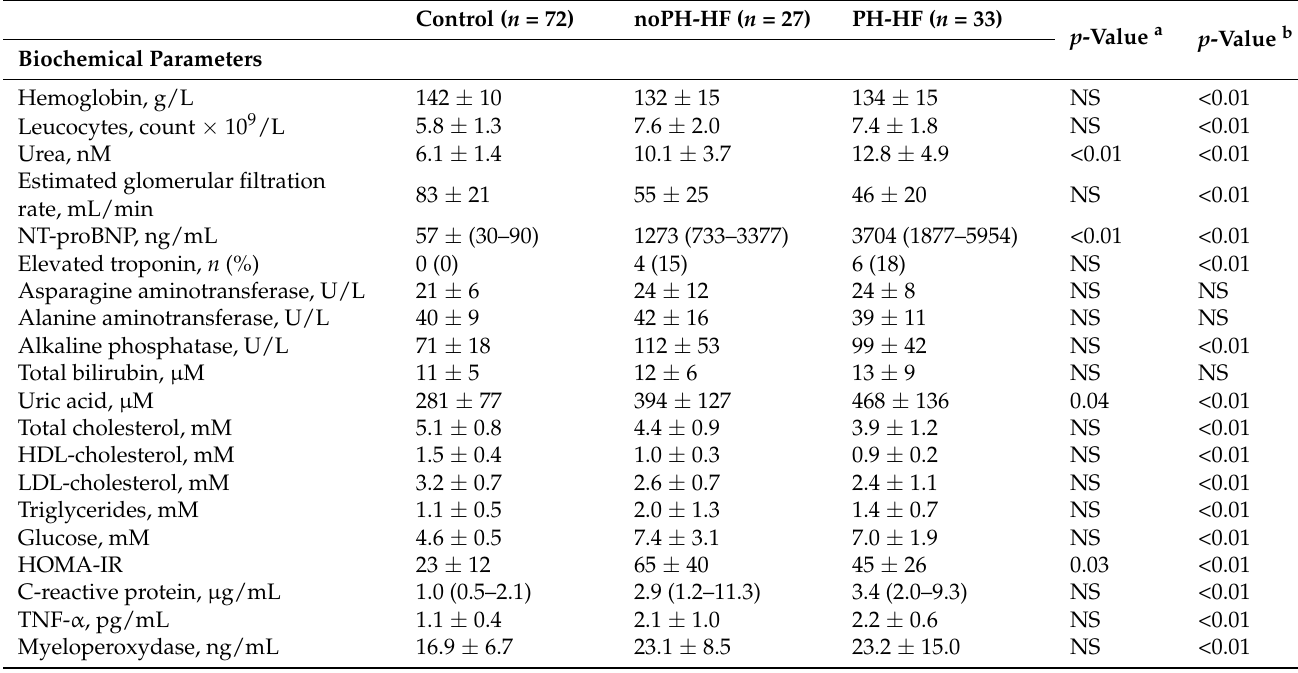
Table 2. Standard biochemical characteristics at baseline by heart failure and pulmonary hypertension